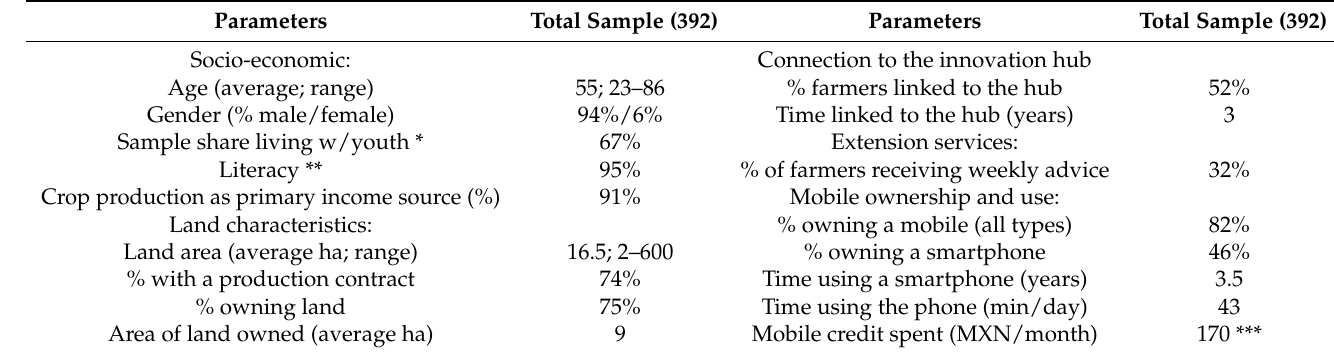
Table 2. Socio-economic, land characteristics, innovation hub, and mobile phone